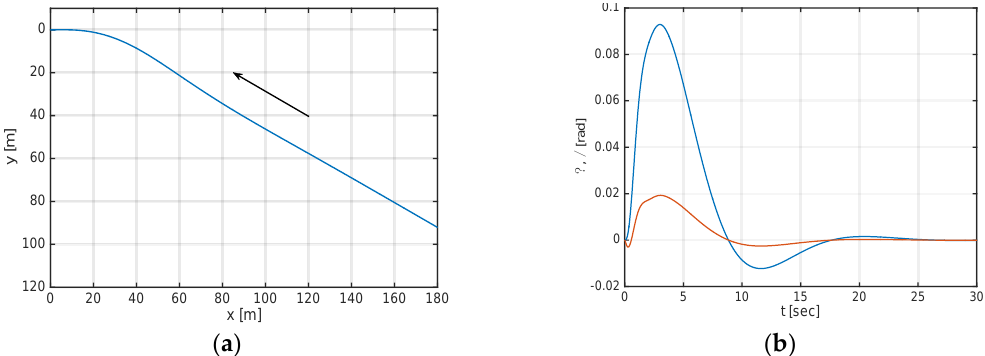
Figure 3. Time series of an uncontrolled bicycle running a constant forward speed of 7.34 m/s against a cross wind of 2.0 m/s at 30 degrees (Beaufort 2, light breeze); ( a ) path of the rear wheel contact point (arrow indicates the wind direction) ( b ) bicycle roll angle (blue) and steer angle (red) as a function of time.